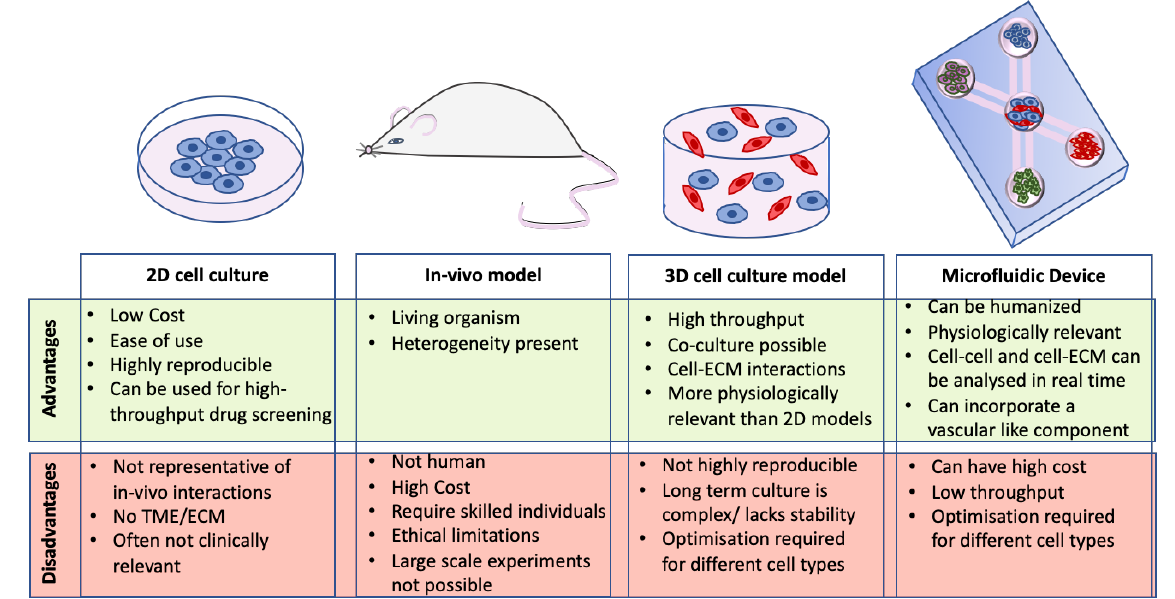
Figure 6. Advantages and disadvantages of CRC models. Each model has different attributes which are desirable for the ideal model of CRC. This figure summarises the major advantages and disadvantages of 2D cell culture models, 3D cell culture models, microfluidic devices, and in vivo models.